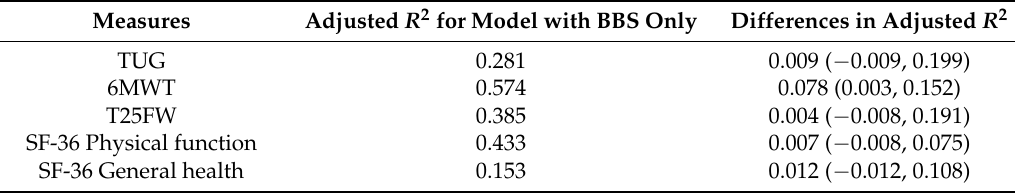
Table 4. Differences in the adjusted R 2 (DGI adjusted R 2 –BBS adjusted R 2